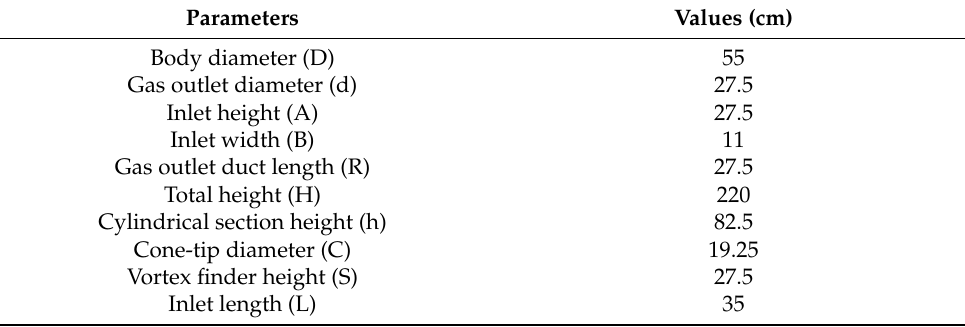
Figure 1. Dimensions of the cyclone. Table 1. Cyclone separator dimensions.